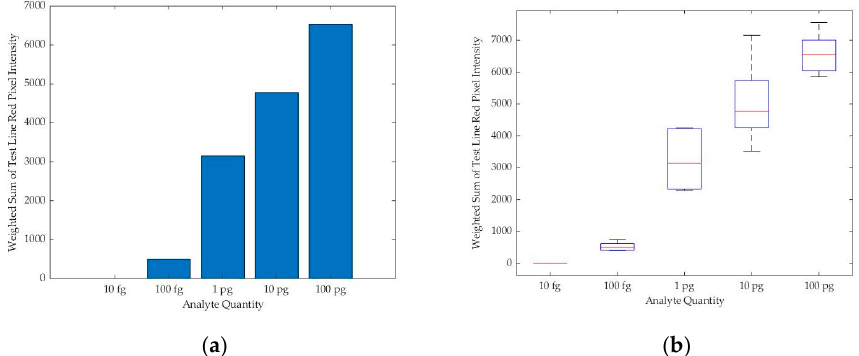
Figure 8. ( a ) Bar chart for the median of the readings for the weighted sum of the test line red pixels’ intensity values against the quantity of analyte present in the sample in a specific lighting condition; ( b ) the boxplot for multiple readings for each analyte quantity.